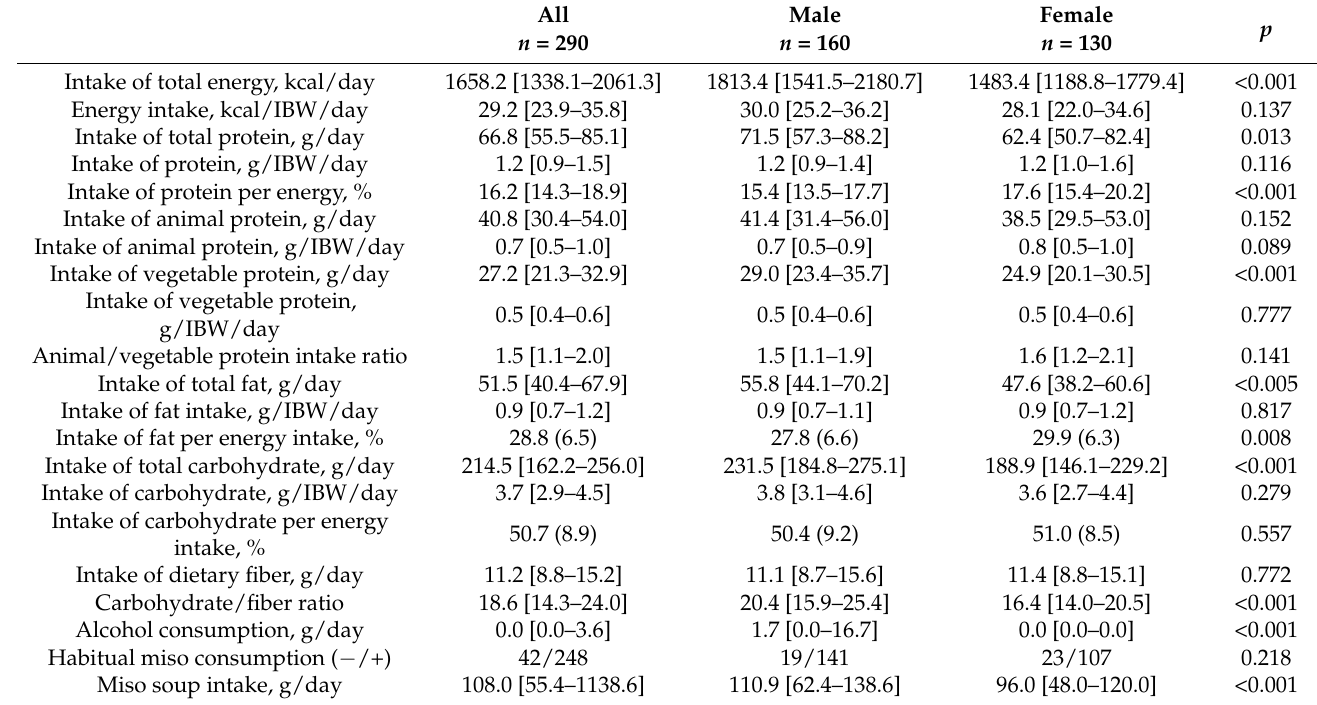
Table 2. Habitual diet intake of study participants.